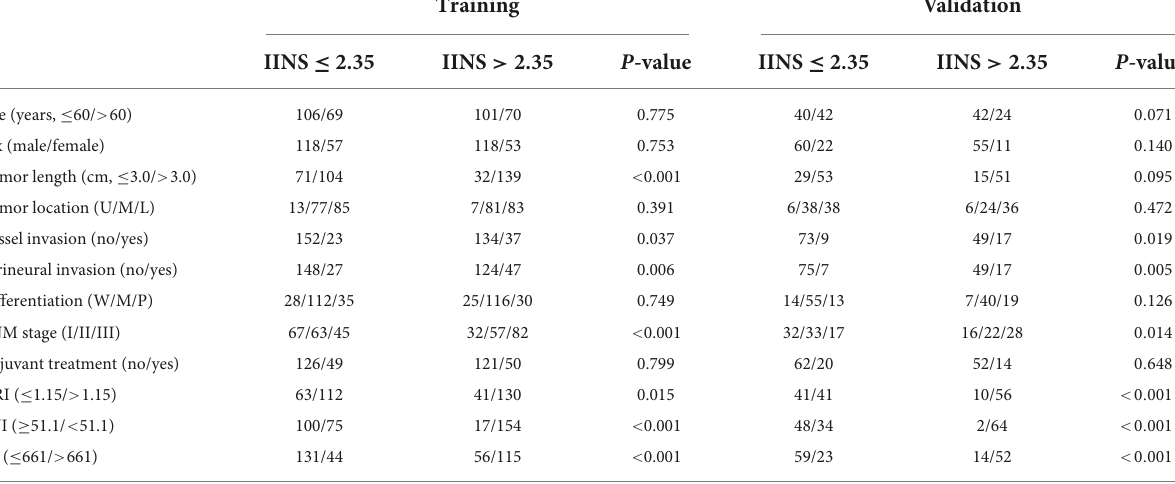
TABLE 2 Comparison of baseline characteristics based on integrative inflammatory and nutritional score (IINS) in training and validation